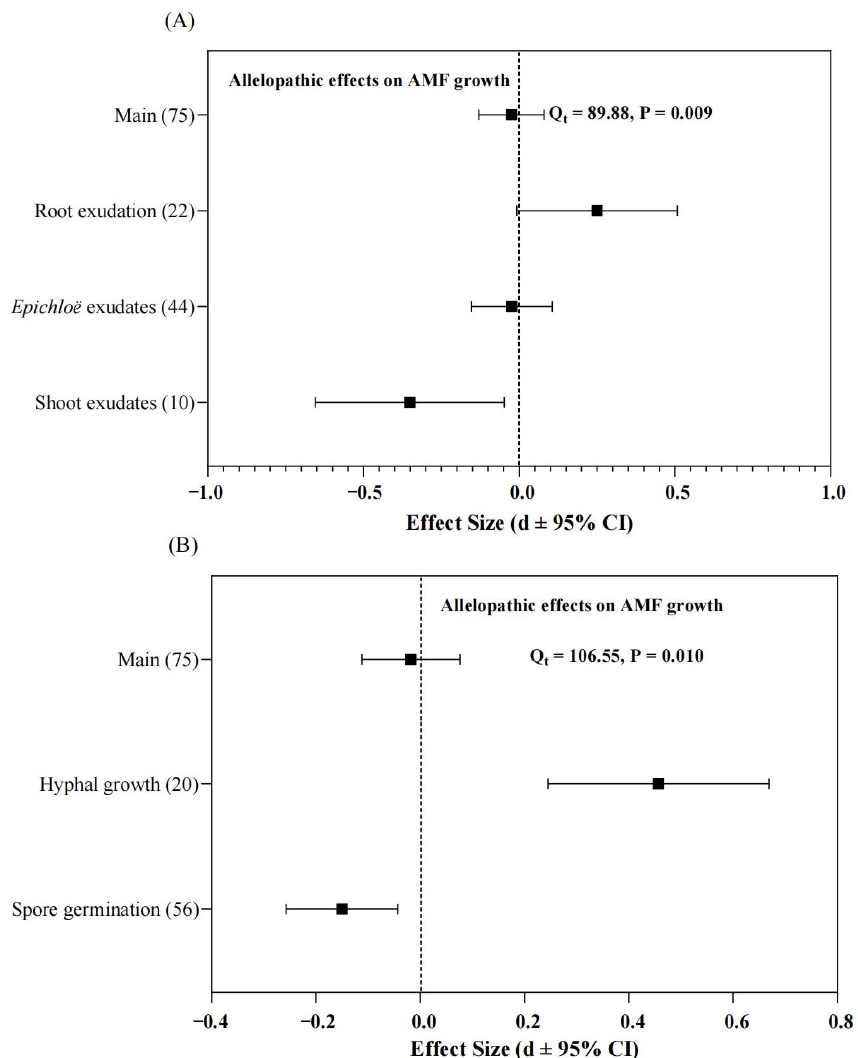
Figure 1. The cumulative effect size of allelopathic effects of Epichloë endophytes on the pre-symbiotic phase of the grass and arbuscular mycorrhizal fungi (AMF) development among ( A ) different allelopathic (exudates from root, shoot, and Epichloë strains) effects, or ( B ) AMF germination and hyphal growth. Squares indicate the mean values and bars denote the 95% confidence interval (CI).